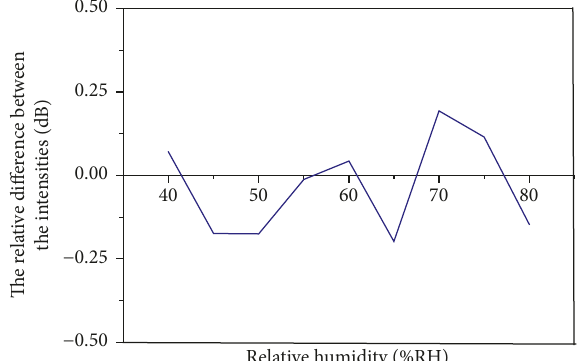
Figure 7: Relation of average relative difference of intensity and humidity.